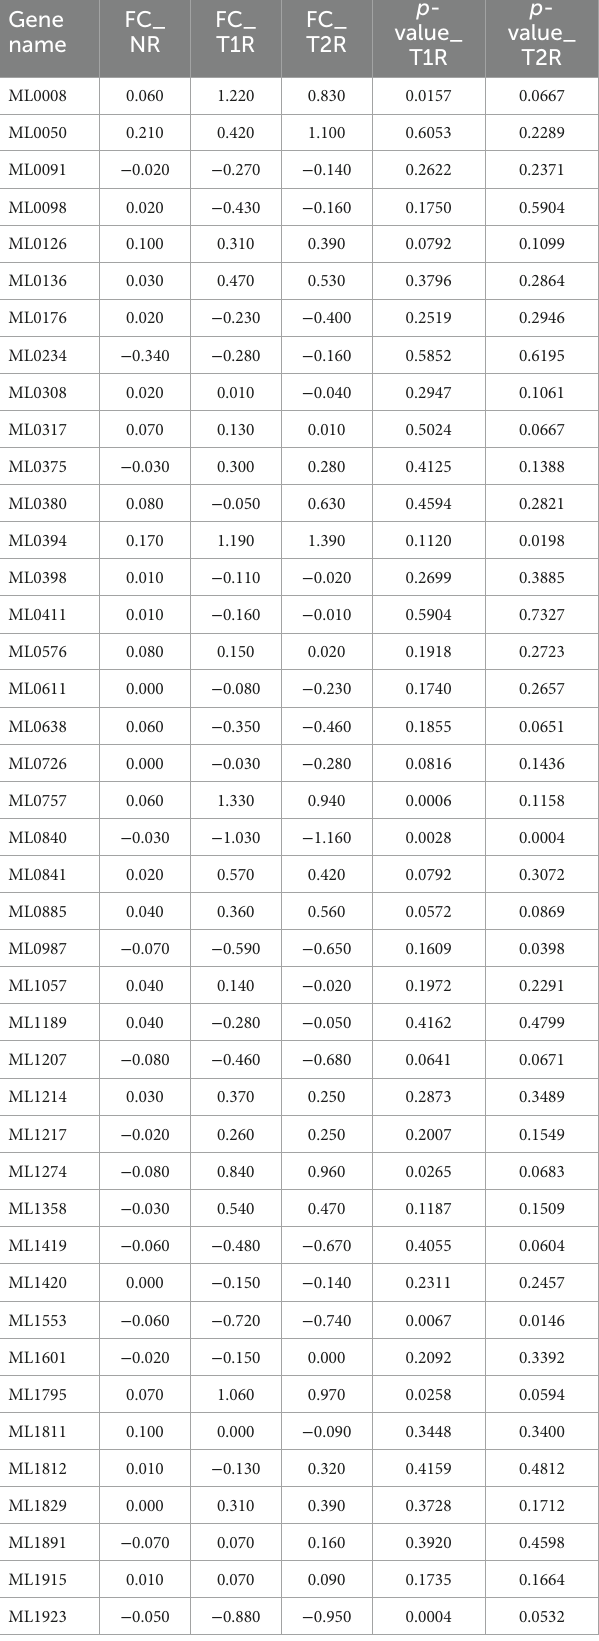
TABLE 3 The log 2 FC for DEGs among the antigen coding genes in immune epitope database (IEDB) database for Mycobacterium leprae. Gene